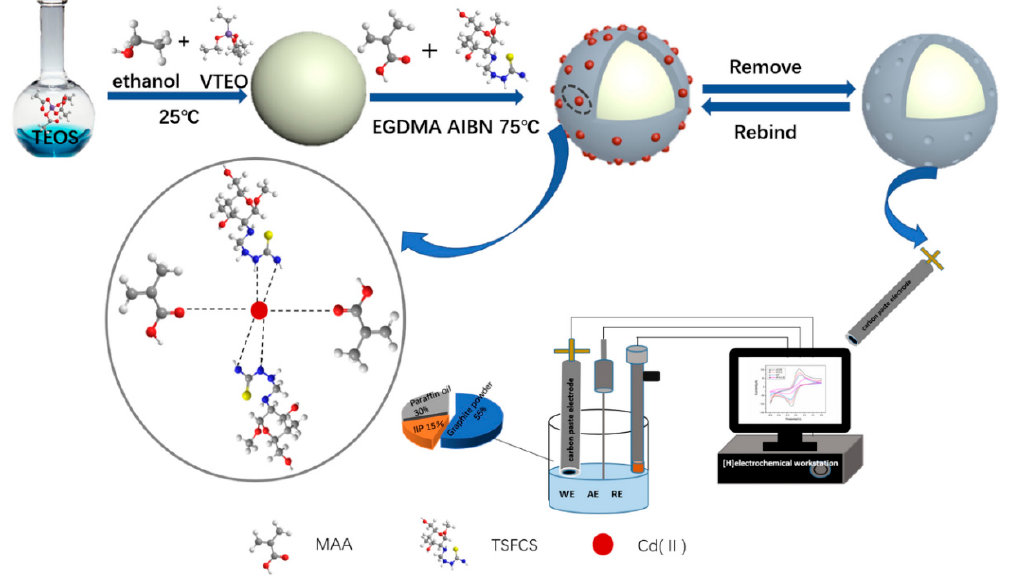
Figure 11. Schematic diagram of the preparation process of Cd 2+ imprinted polymers. Reprinted with permission from Ref. [123]. Copyright 2021, the Springer Nature.